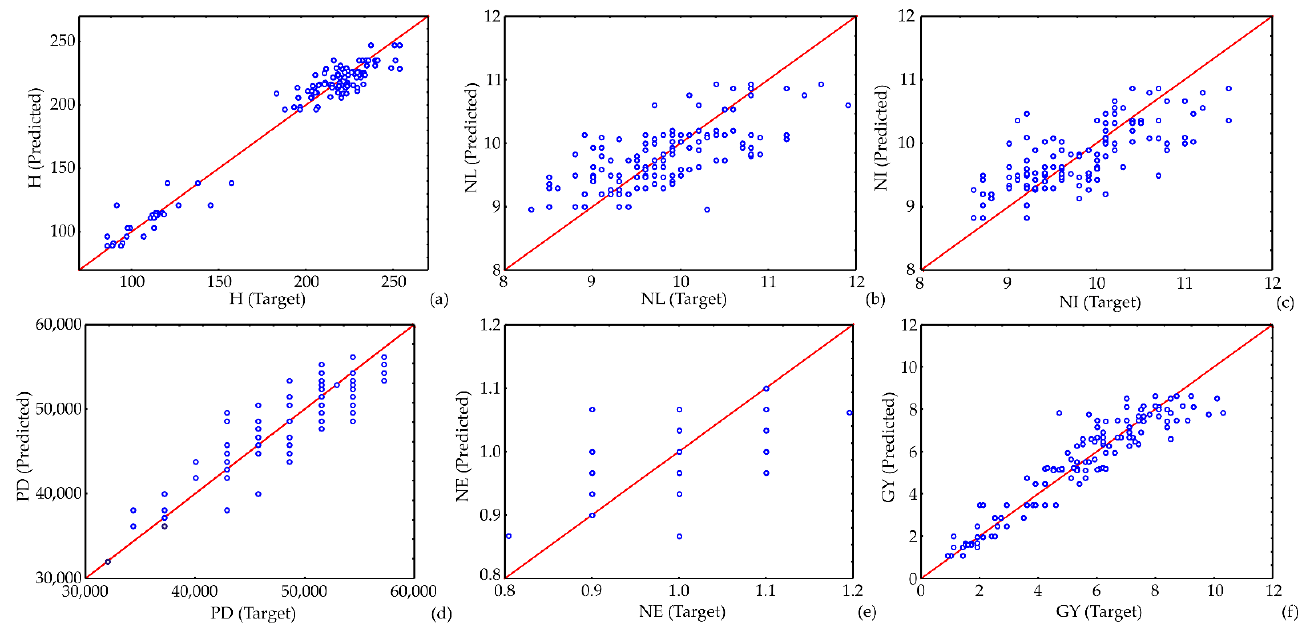
Figure 4. Comparison of experimentally obtained values of ( a ) H, ( b ) NL, ( c ) NI, ( d ) PD, ( e ) NE, and ( f ) GY, with ANN predicted values.